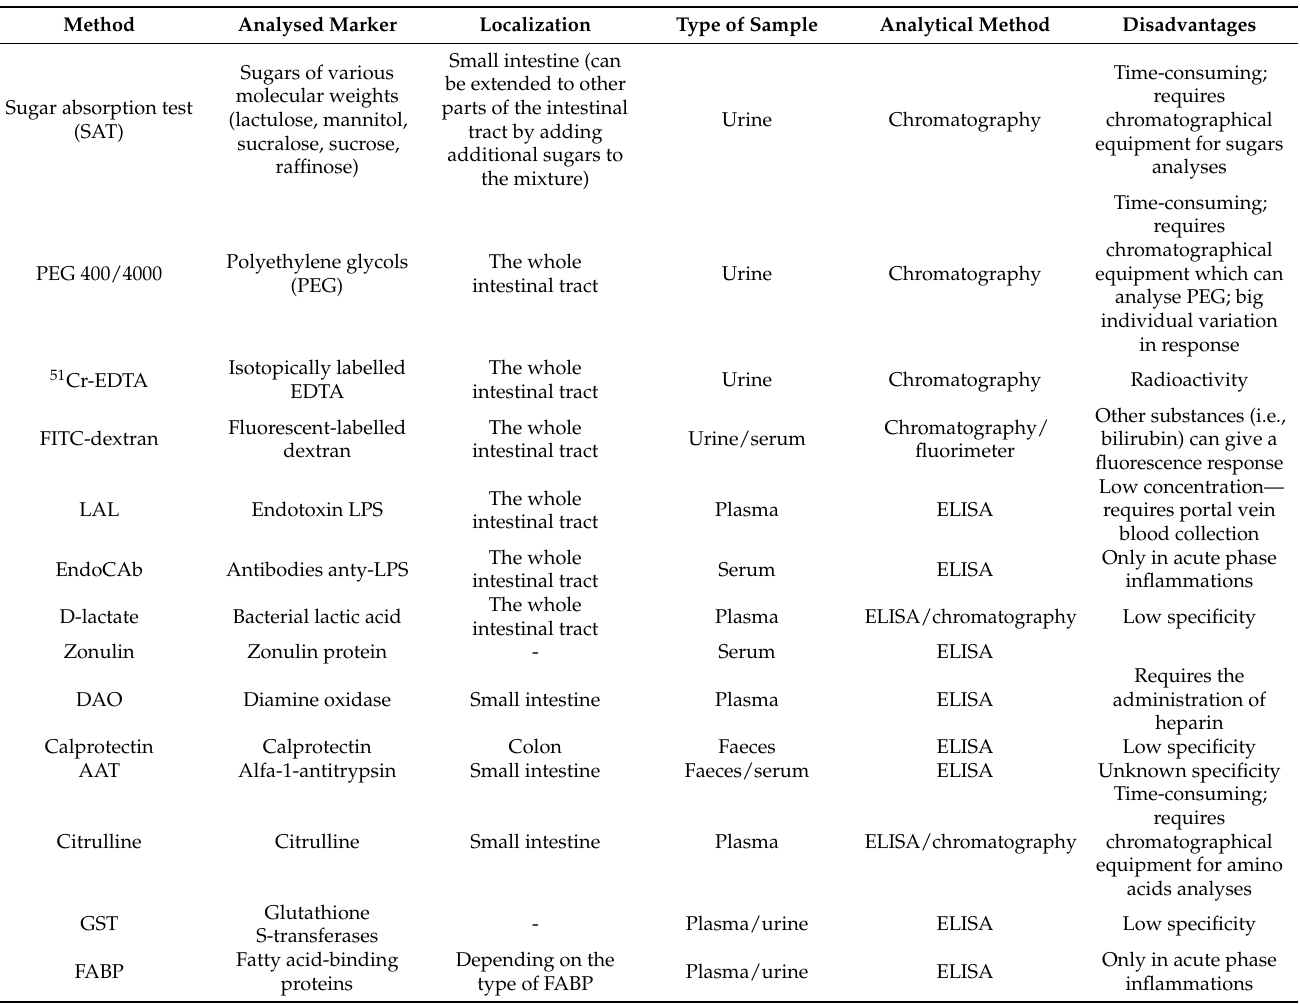
Table 1. The characteristics of the methods for assessments of intestinal